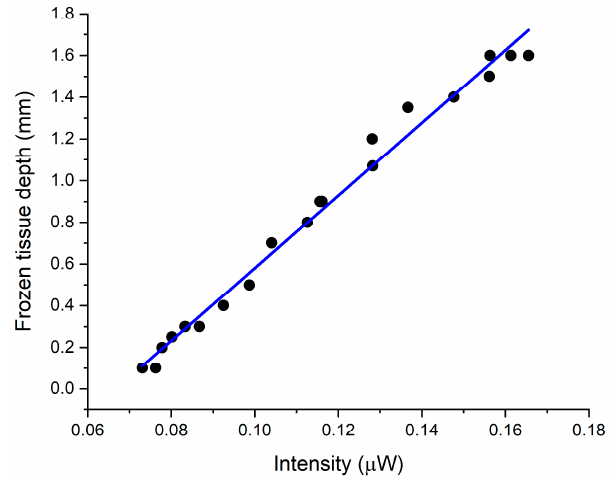
Figure 13. Correlated data from the backscattering intensity from fiber 3, plotted as function of frozen skin depth as measured by the ultrasound.